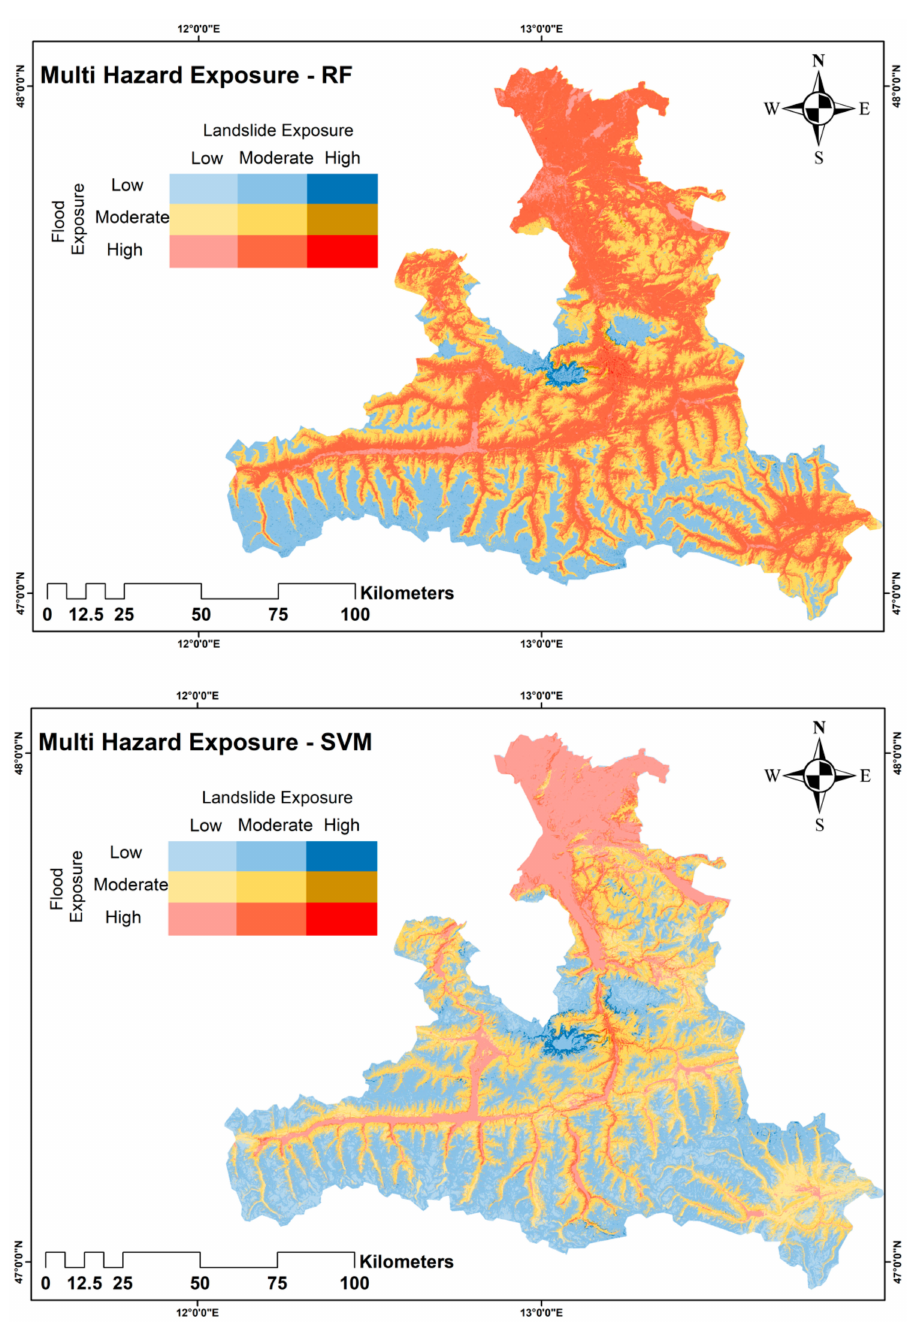
Figure 7. Integrated multi-hazard exposure classification combining flood and landslide using random forest and support vector machine for the State of